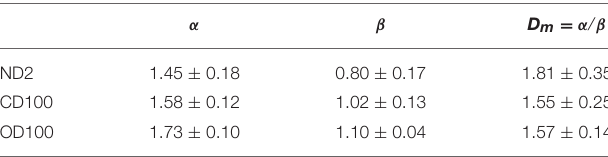
Finger opening, i.e., parts of the air cluster empty of beads, is observed in regions where the volumetric strain exceeds 0.05.